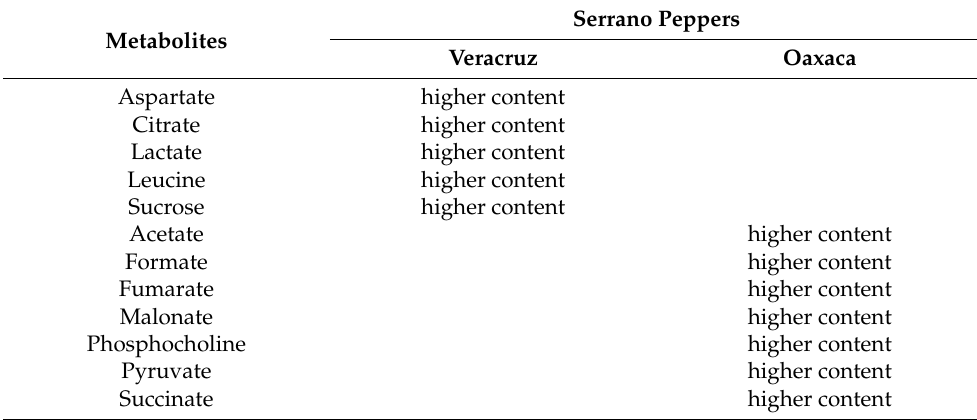
Table 5. Differences in the metabolites contents with respect to geographical origin of Serrano peppers. Metabolites